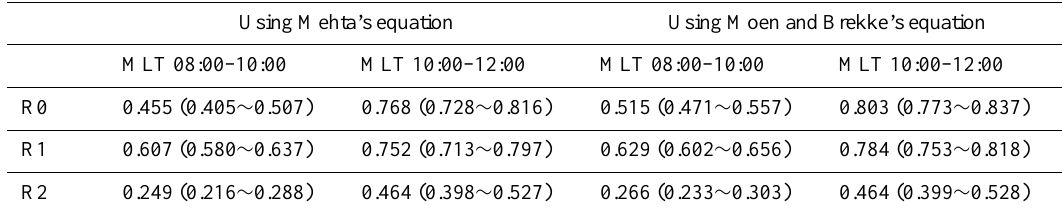
Fig. 3. The relationship between the FAC intensity and the ionospheric conductivity for a current source case and a voltage source case. We assume FAC flowing on closed (open) field lines in upper (lower) two panels. Table 1. The correlation coefficients between the FAC intensity and the ionospheric conductivity. Using Mehta’s equation Using Moen and Brekke’s